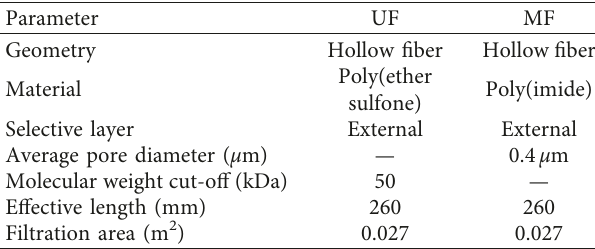
Table 2: Parameters of the ultrafiltration (UF) and microfiltration (MF)